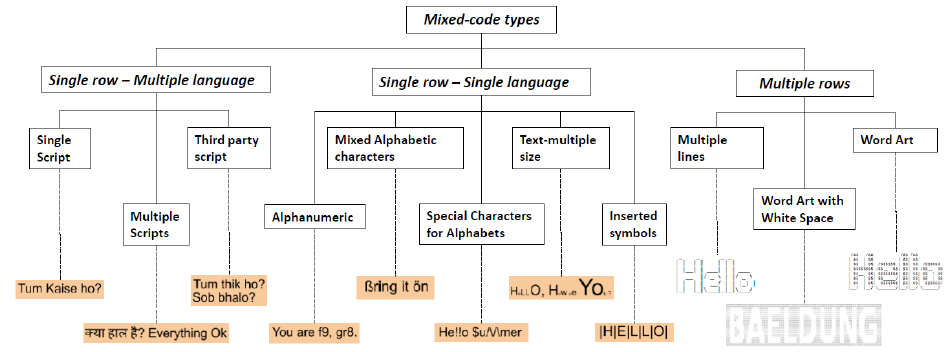
Figure 1. Mixed-code